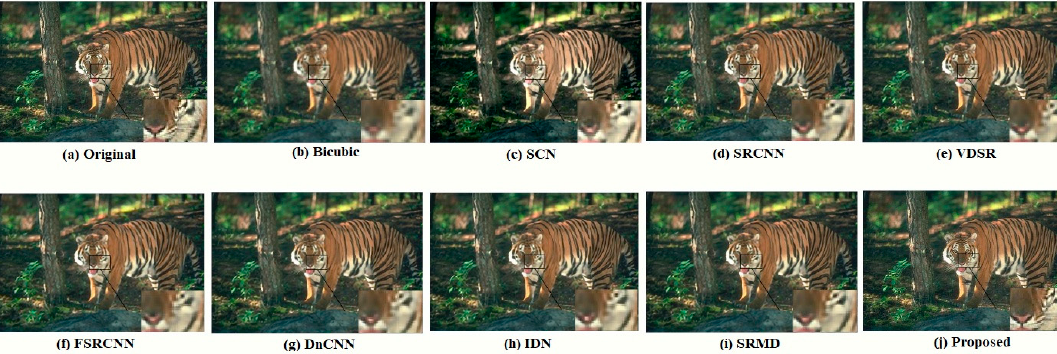
Electronics 2019 , 8 , x FOR PEER REVIEW Figure 8. Visual comparison for the tiger image at the scale-up factor of 3. Figure 8. Visual comparison for the tiger image at the scale-up factor of 3. Figure 8. Visual comparison for the tiger image at the scale-up factor of 3.